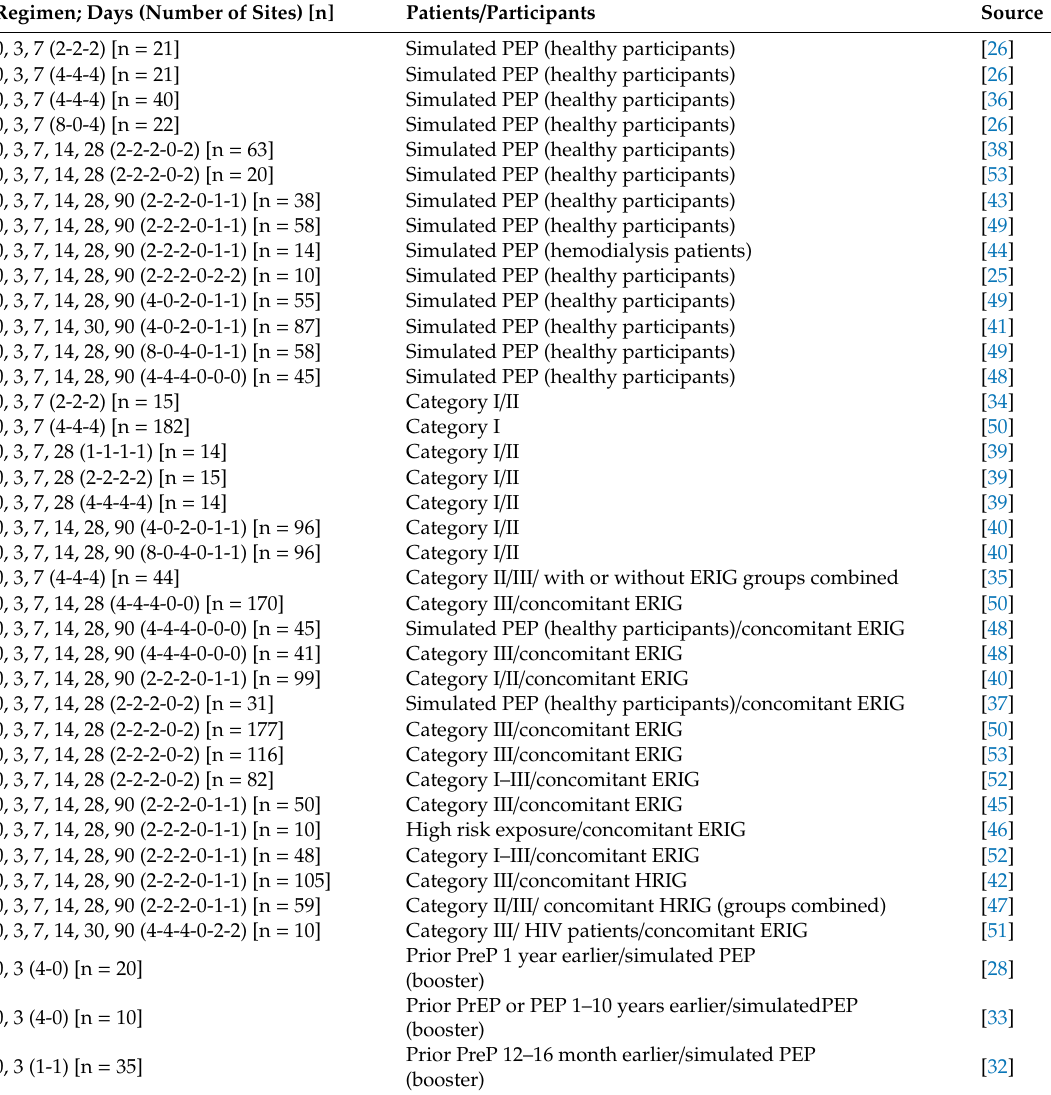
Table 1. PEP ID regimens